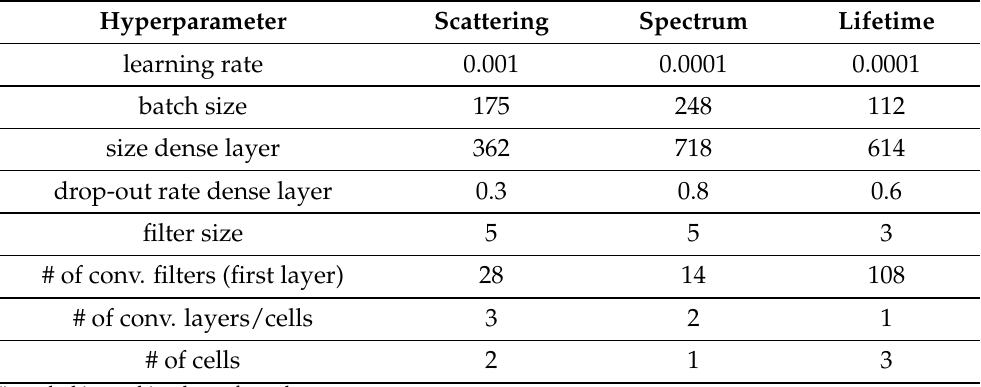
Table 4. Best hyperparameters. Hyperparameter tuning was performed independently for each FE; thus, the best configuration of hyperparameters is shown independently for each one.